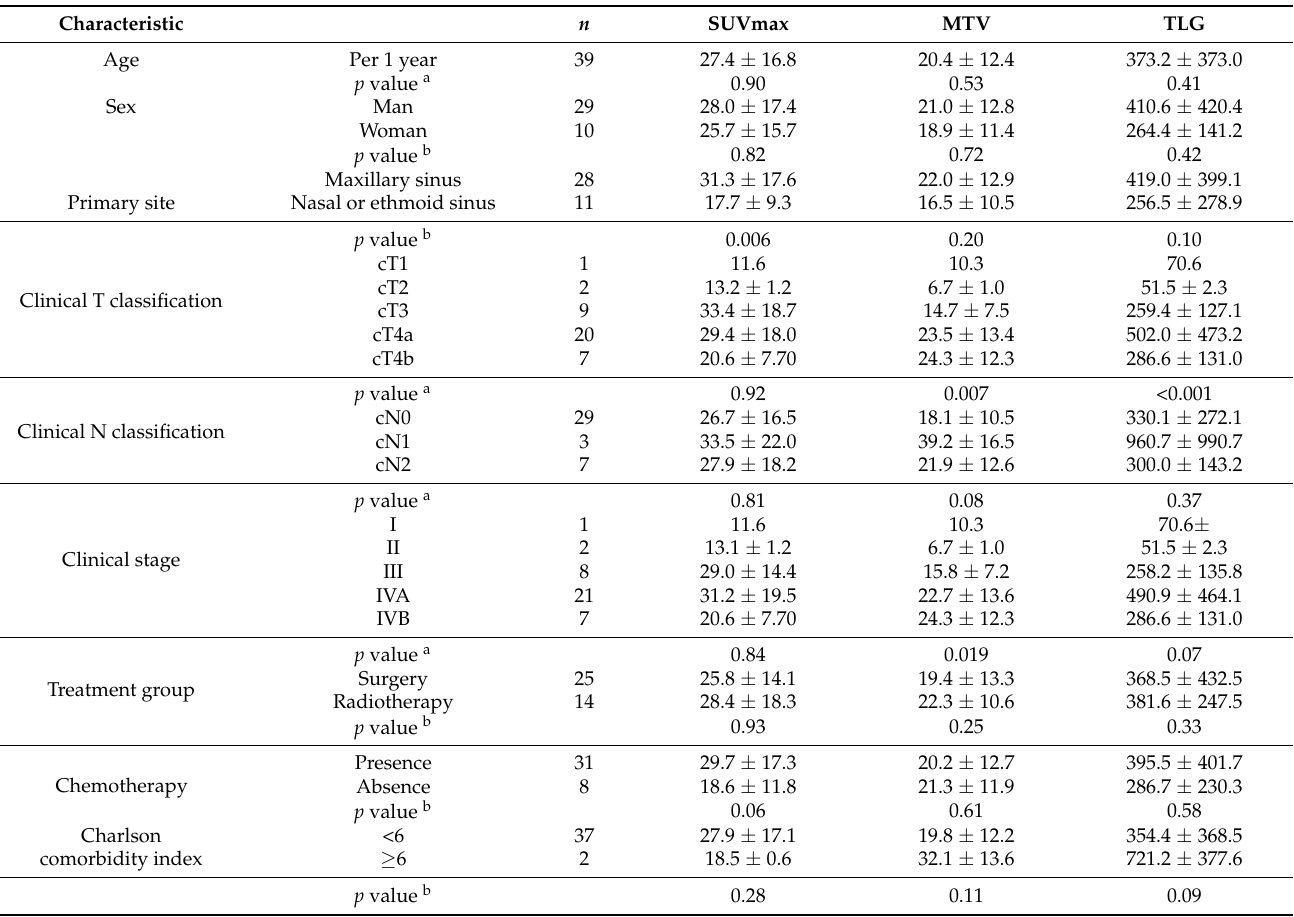
Table 1. Association between F18-FDG uptake parameters (SUVmax, MTV, TLG) and clinical charac- teristics in 39 patients with sinonasal tract SCC.